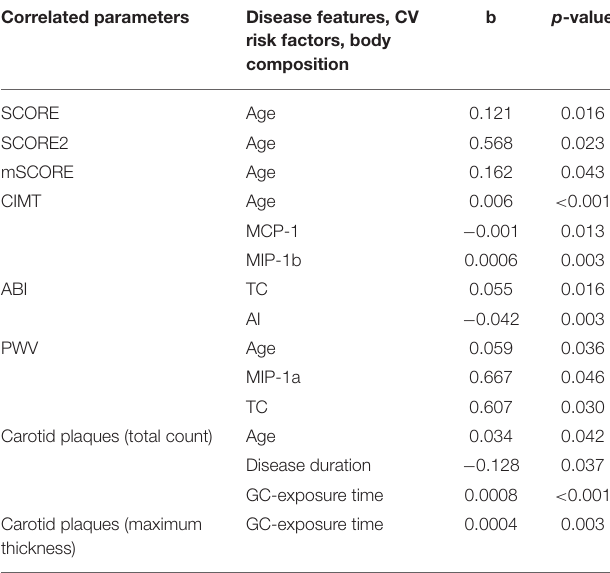
TABLE 10 | Association of cardiovascular risk and subclinical atherosclerosis markers with disease-specific features, body composition parameters, and traditional risk factors in IIM, based on multivariate regression